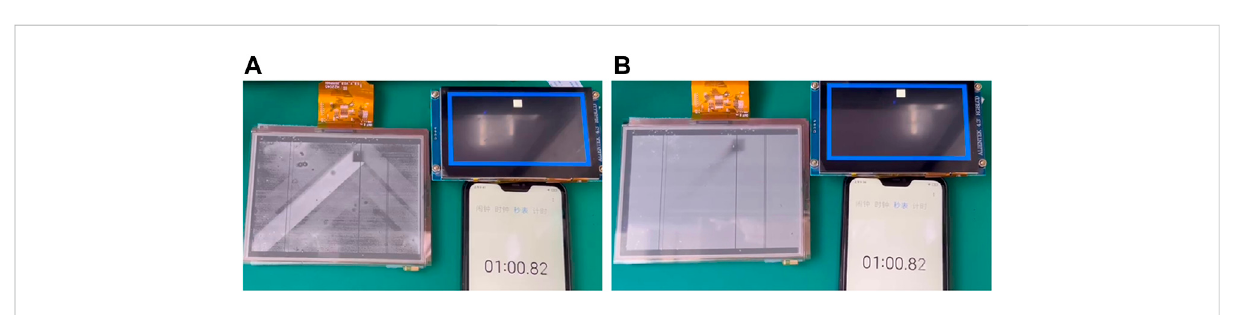
FIGURE 13 The EWD video display with different methods. (A) Traditional method (DC driving waveform). (B) Asymmetric IF AC driving model (Proposed mothed).